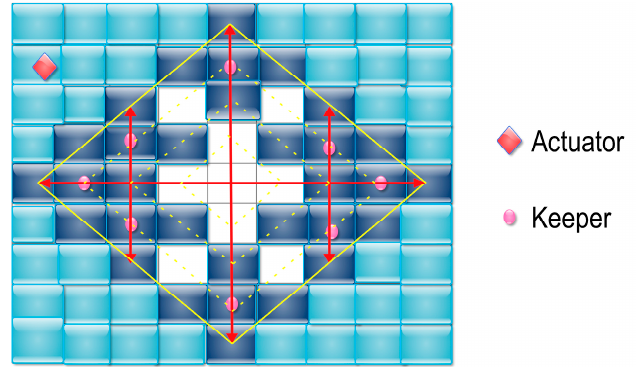
Figure 4. The ballooning strategy (the keepers are the sensor nodes who received the searching messages generated by the source; the white grids represent the cleared grids, the deep blue grids are the contaminated grids, and the light blue grids represent the clearing grids) [54].